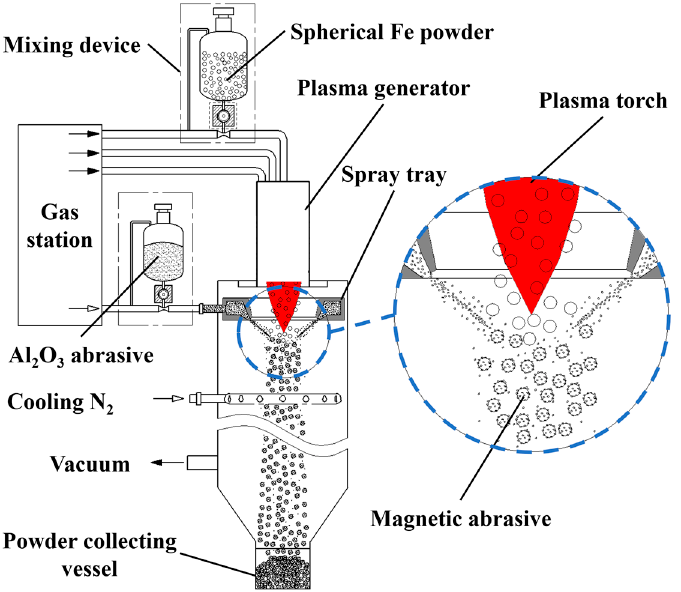
Figure 1. Schematic diagram of combining plasma molten metal powder with sprayed abrasive